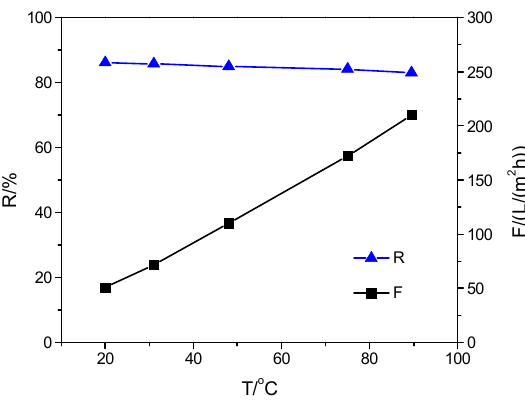
Figure 2. Influence of operating temperature on the properties of SPPES composite membrane.